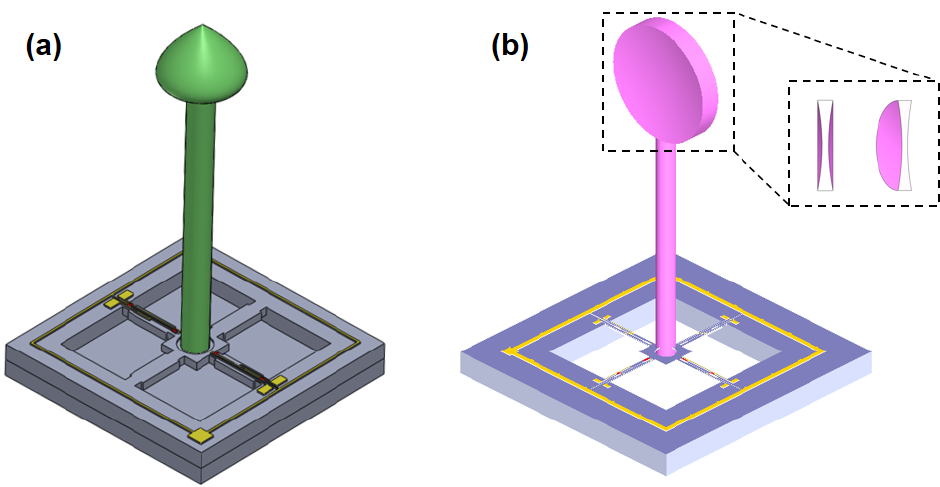
Figure 3. ( a )Traditional ciliated global microstructural model; ( b ) Integrated microstructure model of concave cilium.